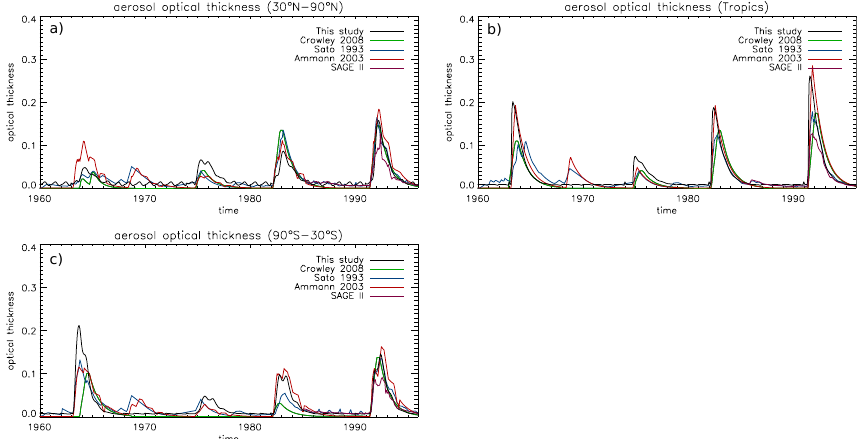
Fig. 12. Total optical depth (AOD) in VIS (550nm) 1960–1996 for the Northern Hemisphere extratropics (a) , tropics (b) , and Southern Hemisphere extratropics (c) . Black line is the AOD from this study, green line is the AOD from Crowley et al. (2008), blue line is the AOD of Sato et al. (1993), red line from Ammann et al. (2003), magenta line is the AOD derived from SAGE II